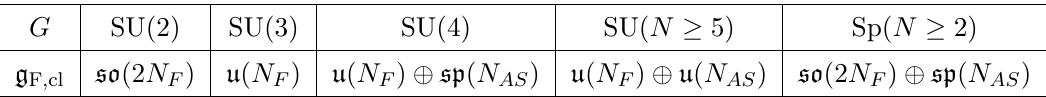
Table 2 . Classical flavor symmetry algebras for gauge theories of the form